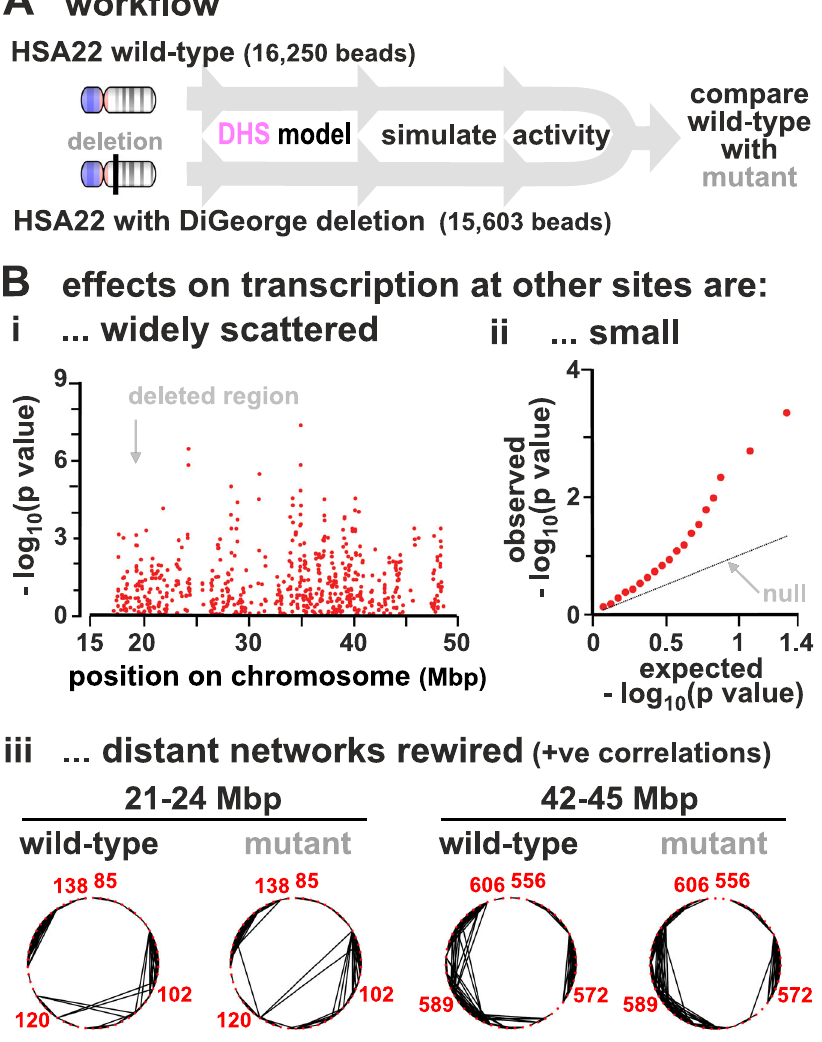
Fig. 8 Modelling effects of the DiGeorge deletion in HSA22. A Work fl ow. Simulations (800 simulations/condition) for wild type (17,102 beads) and deletion (16,250 beads, where wild-type beads 6305 – 7156 are cut, corresponding to a deletion of chr22:18,912,231 – 21,465,672 in hg19). [Agreement between predicted transcriptional activity and GRO-seq in HSA22 is similar to that found for HSA14 (here, Spearman correlation is r ~ 0.29, p < 10 − 6 ; two- sided Student ’ s t -test).] B (i) Manhattan plot showing (cid:1) log 10 ( p value) as a function of genomic position along HSA22 (position given in Mbp), for changes in TU transcriptional activities between wild type and deletion. (ii) Quantile – quantile plot showing expected versus observed values for (cid:1) log 10 ( p value) for the same data in (i). Expected values are computed from the normal distribution (these correspond to the null hypothesis according to which the change in transcriptional activities in the deletion is purely due to random variation). (iii) Regulatory networks of two 3 Mbp segments in chromosome 22 inferred from the Pearson correlation matrix. Edges show positive correlations >0.12 ( p = 0.0007). Segments chosen have roughly the same number of nodes in 3 Mbp as the short fragment (Fig.